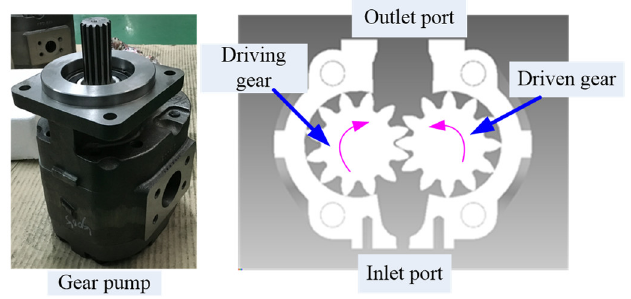
Figure 2. Gear pump structure diagram.